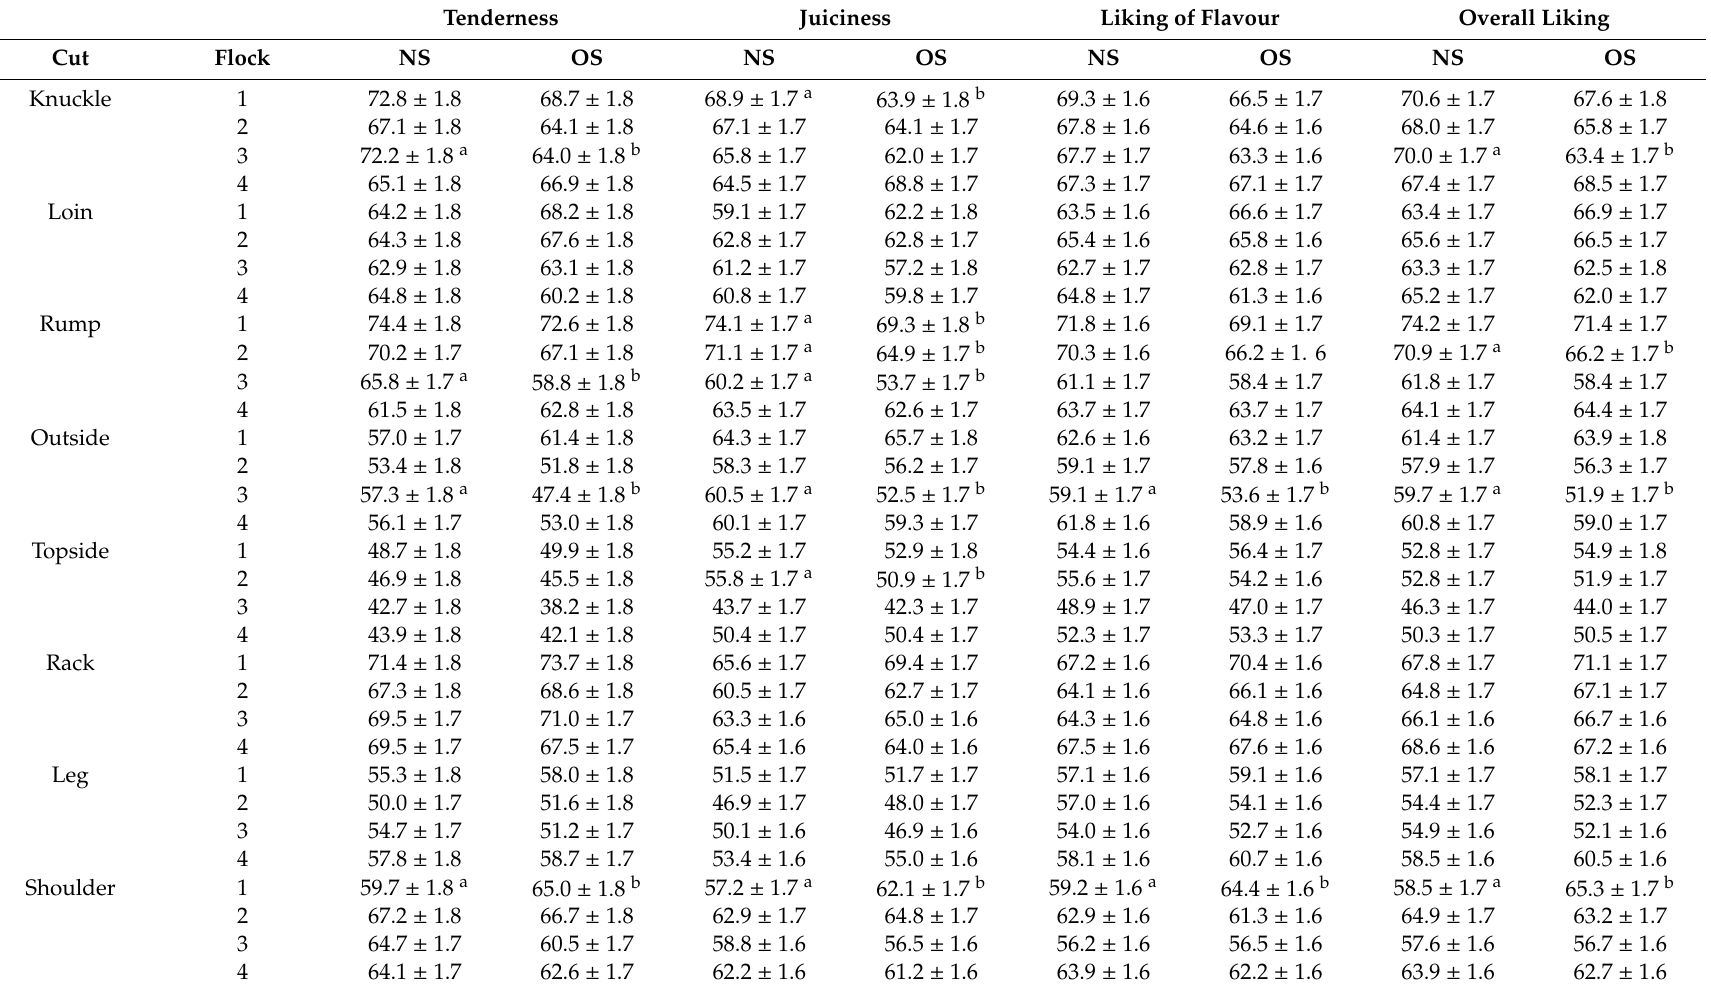
Table 4. Sensory properties of cuts from new season (NS) and old season (OS) lambs within each flock (least square means ± S.E). Tenderness Juiciness Liking of Flavour Overall Liking Cut Flock Knuckle